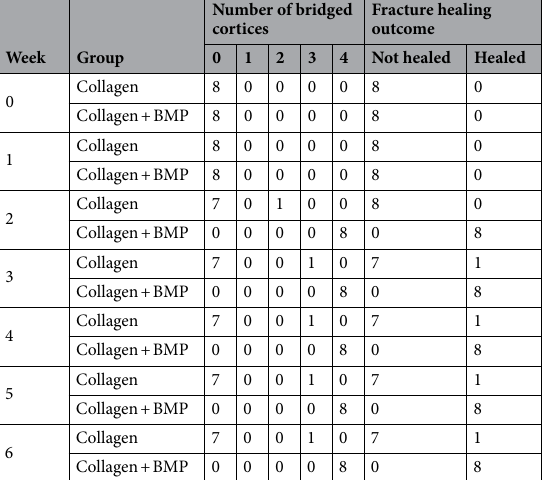
Table 2. Number of bridged cortices per callus evaluated weekly in two perpendicular planes and number of mice with successful fracture healing in the collagen and the collagen + BMP-2 groups (≥ 3 bridged cortices, threshold 395 mg HA/cm 3